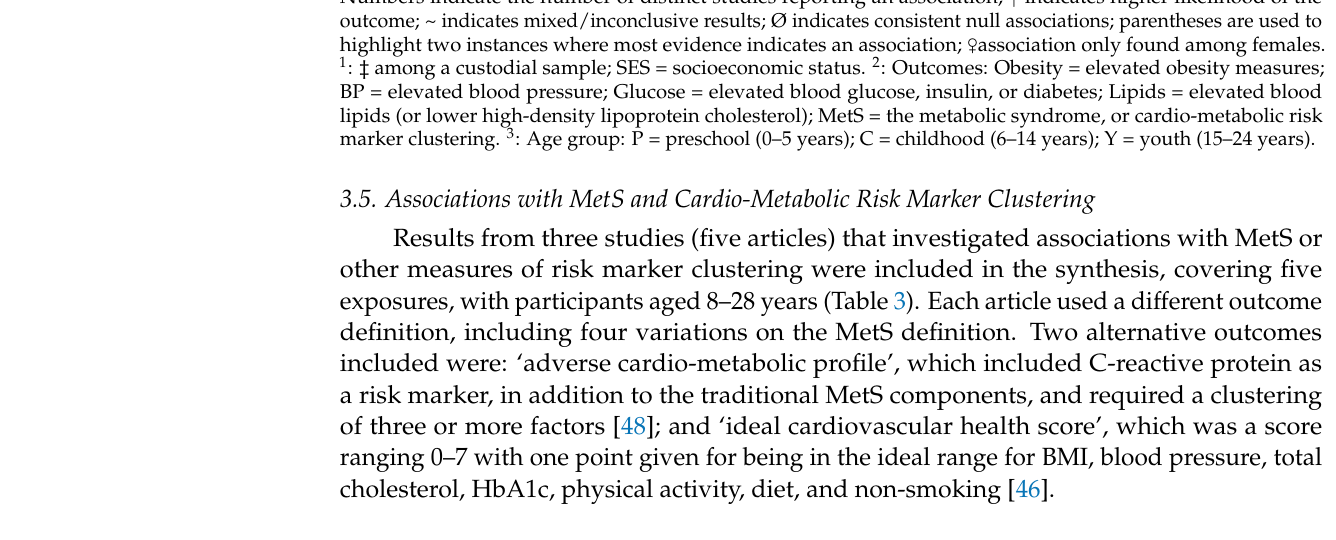
Table 3. Quantitative associations with the metabolic syndrome (MetS) or cardio-metabolic risk marker clustering, arranged by exposure type and listed in order of lowest to highest risk of